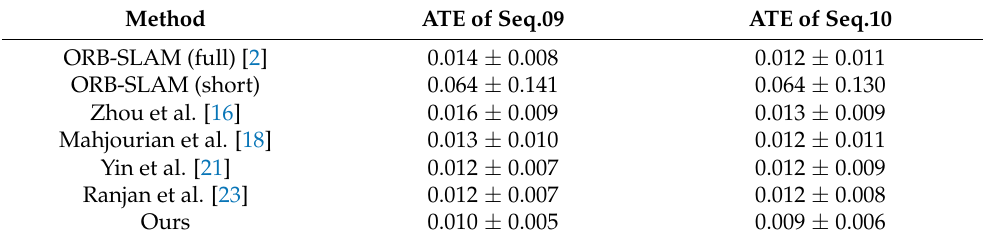
Table 2. Comparison of ATE with different methods on KITTI VO